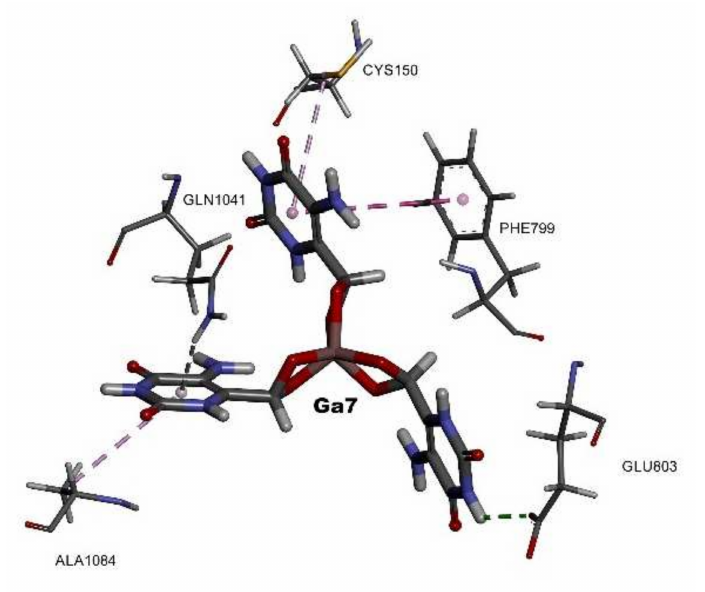
Figure 6. The 3D structure of the gallium(III) complex presented as sticks and colored by CPK with the involved amino acids inside the active site of the HXO.